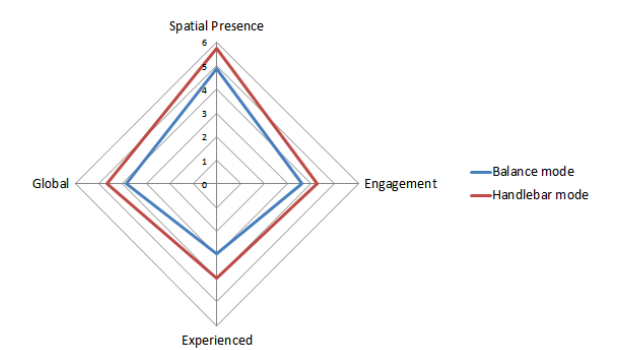
Figure 11. Mean values for the IPQ questionnaire in the Balance mode (blue bars) and Handlebar mode (red bars) at the second